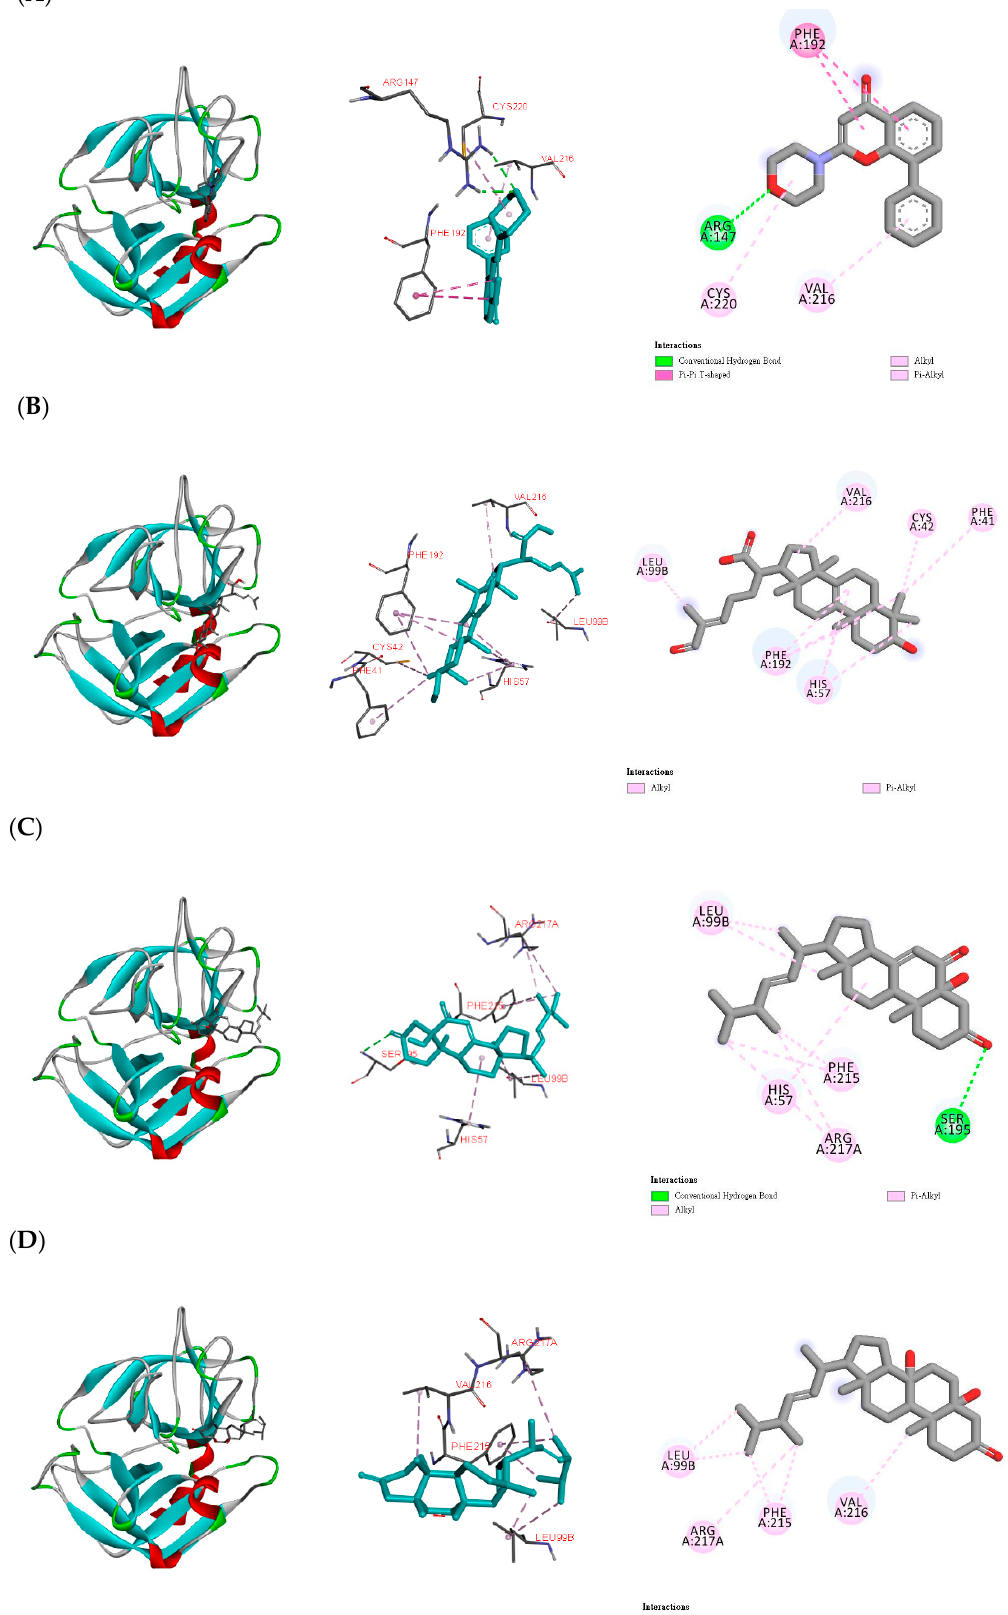
Figure 5. In silico modeling of ( A ) LY294002, ( B ) 5 , ( C ) 14 , and ( D ) 19 docking into the human neutrophil elastase.